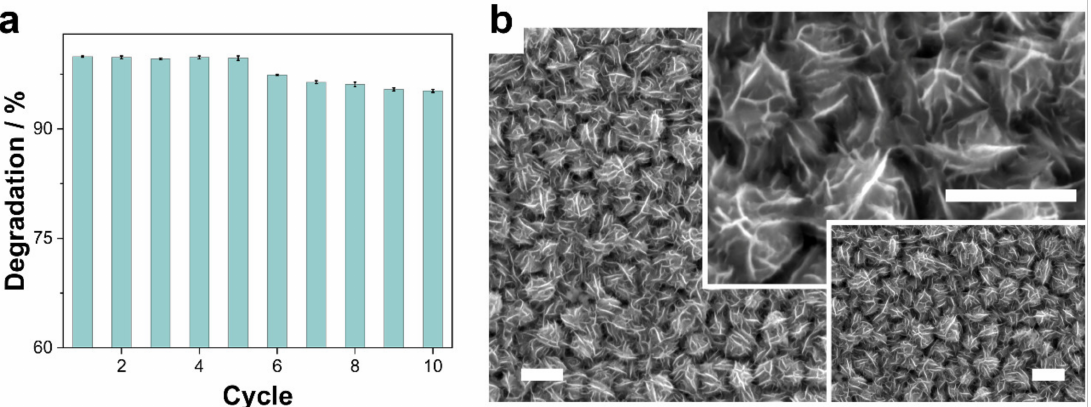
Figure 8. ( a ) Degradation ratio (60 min) of TC using Co–CoNi annealed at 350 ◦ C catalyst for 10 reusability cycles; ( b ) FE-SEM micrographs Co–CoNi annealed at 350 ◦ C after use for 10 reusability cycles. Scale bar: 1 µ